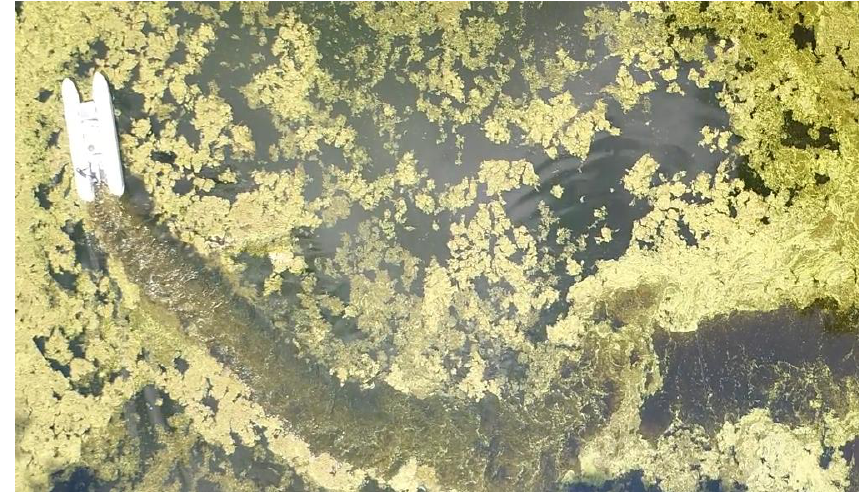
Figure 17. ( a ) Battery voltage measurements for multiple test runs and ( b ) characterization of chemical dispersal rates as a function of RC input. Voltage fluctuations were a function of power supplied to the propulsion system.